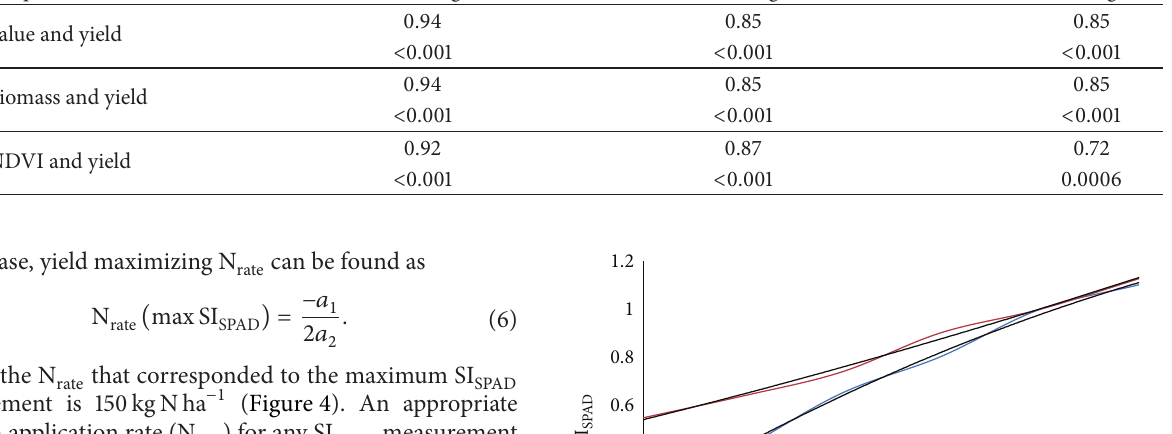
Table 4: Pearson correlation coefficients among sensor attributes at different growth stages and crop yield. Relationship between